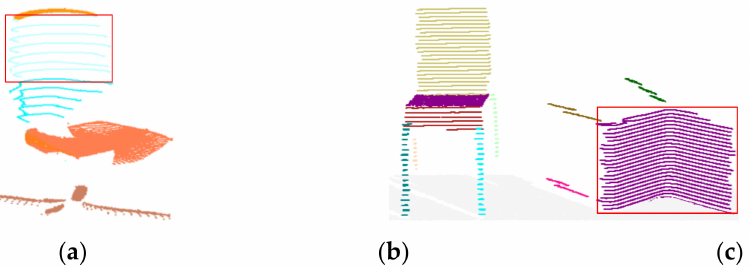
Figure 14. Limitations: ( a ) Objects with special shaped components; ( b ) Objects with normal posture; ( c ) Objects with abnormal